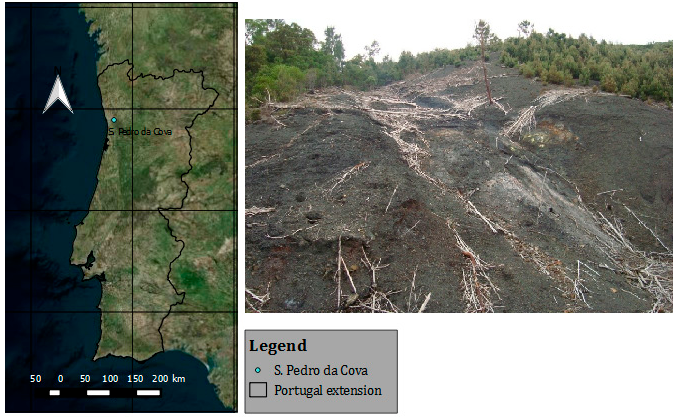
Figure 1. General view of the active self-burning area in S. Pedro da Cova waste pile (base map source: Bing Aerial, Imagery of NASA Earthstar Geographics SIO© 2016).